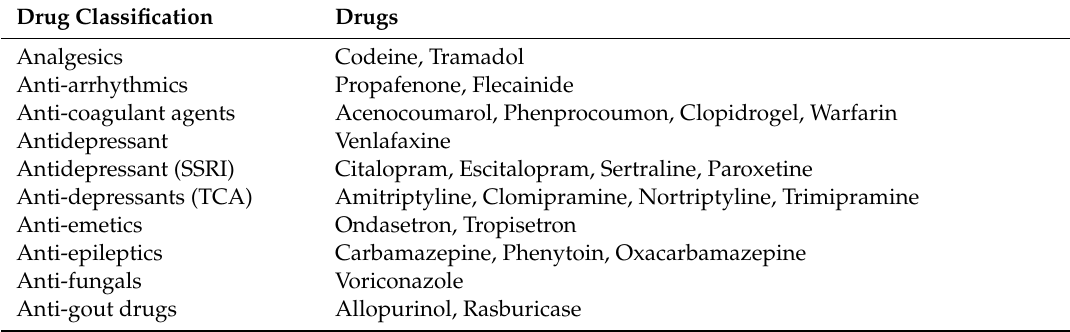
Table 1. Drugs included in FARMAPRICE clinical decision support system